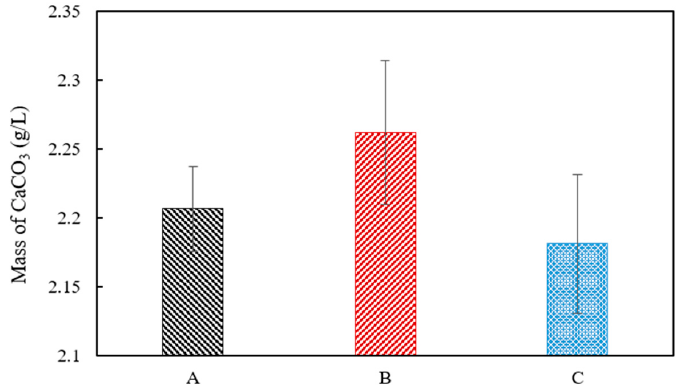
Figure 5. Dry weight of precipitated CaCO 3 at urea–calcium lactate medium at 33 h.